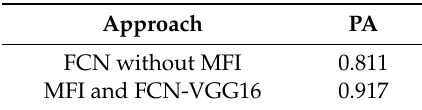
Table 2. Average detection accuracy.